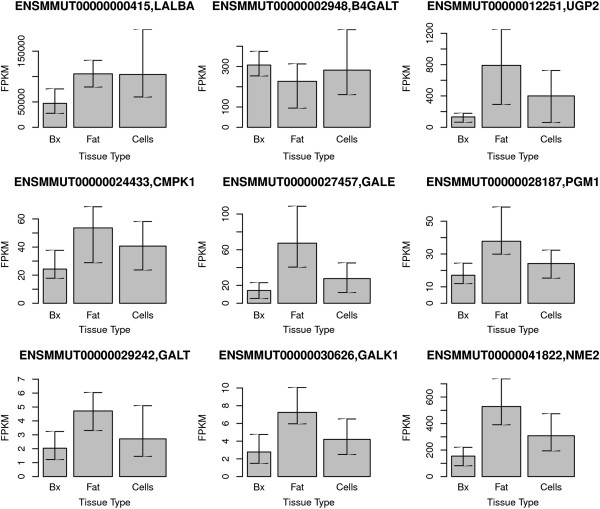
Abundances of transcripts that code for proteins in the lactose synthesis pathway. All differences between mammary biopsy (“Bx”) and milk fat samples (“Fat”) were significant. Differences between milk fat (“Fat”) and milk cell (“Cells”) samples were significant for all transcripts except LALBA and B4GALT.